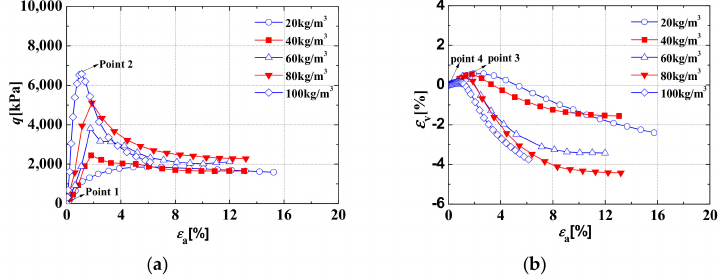
Figure 1. The curves of the triaxial tests for cemented sand and gravel (CSG) material with the confining pressure of 300 kPa: ( a ) the stress–strain curves; ( b ) the volumetric strain-axial strain